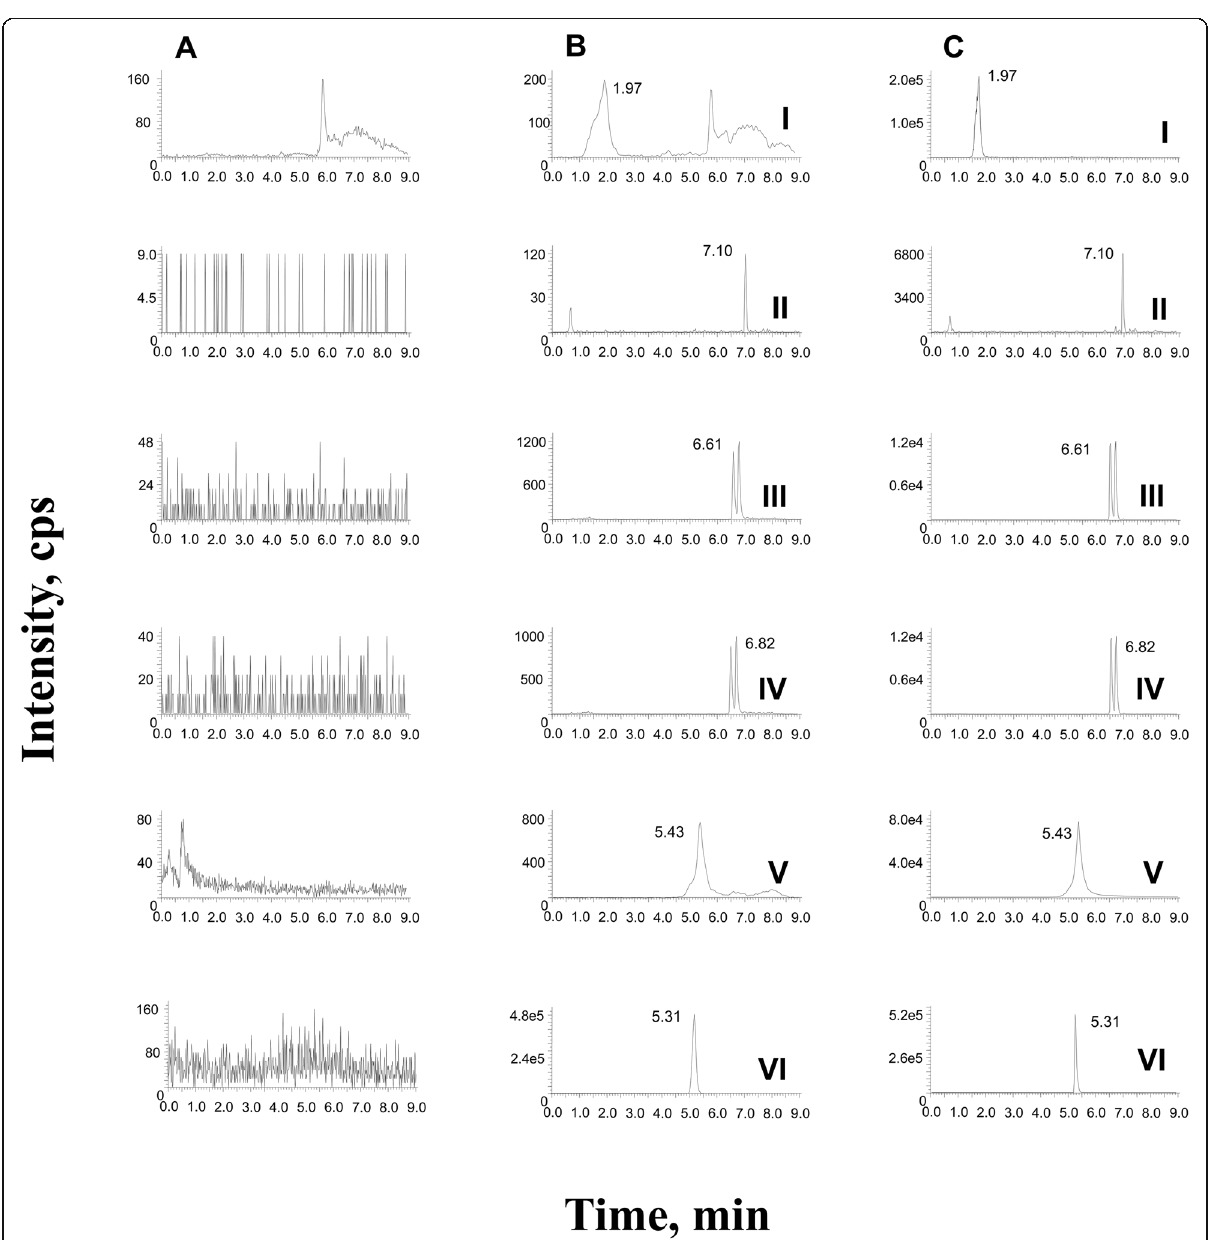
Fig. 2 Typical MRM chromatograms of gastrodin (I), parishin A (II), parishin B (III), parishin C (IV), parishin E (V), and bergenin (I.S., VI) in rat plasma. a A blank rat plasma sample. b A spiked plasma sample with the analytes at LLOQ QC level and I.S. c A plasma sample collected at 1 h from a rat after oral G. elata extract